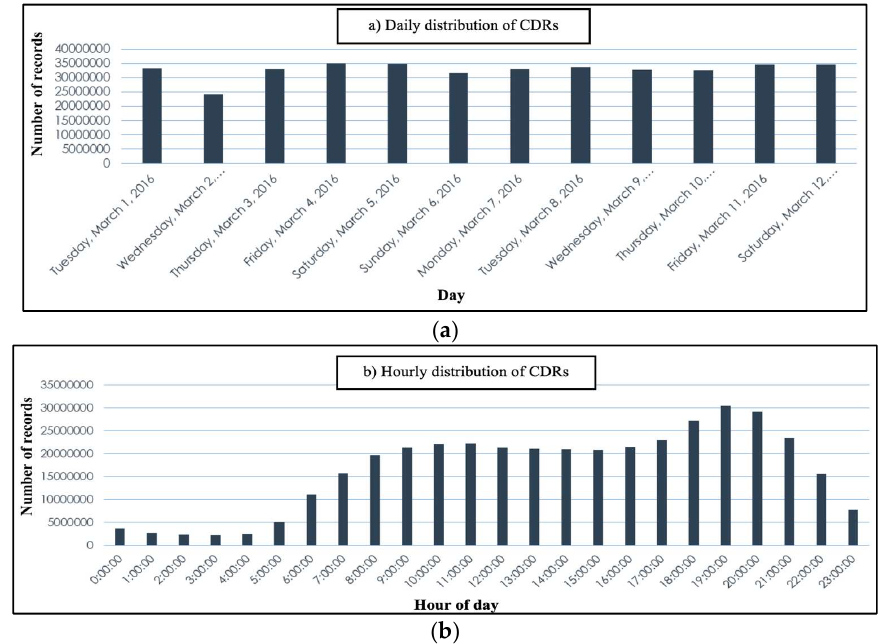
Figure 2. Temporal distribution of the call detail record (CDR) dataset: ( a ) daily, and ( b ) hourly.